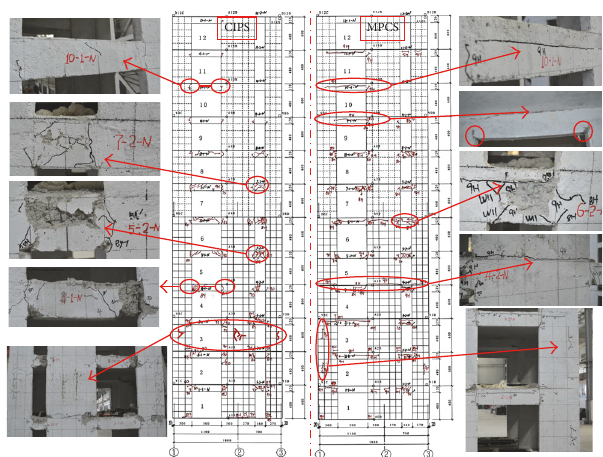
Figure 6: Failure patterns of CIPS and MPCS.